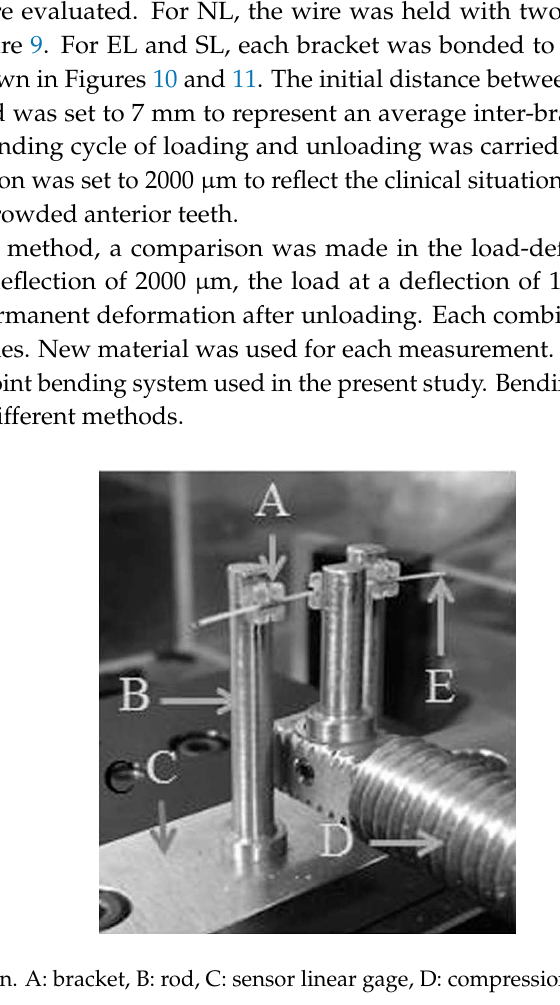
Figure 10. Elastomeric ligature. Figure 11. Slot lid ligature. 4.3. Stress Relaxation Tests Each wire was ligated in the brackets by SL, as described above, by using the modified three- point bending system. Then, the wire was deflected at 2000 μ m and maintained at the same position